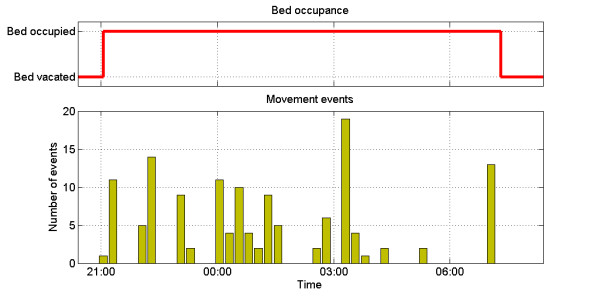
Regular sleep cycle.